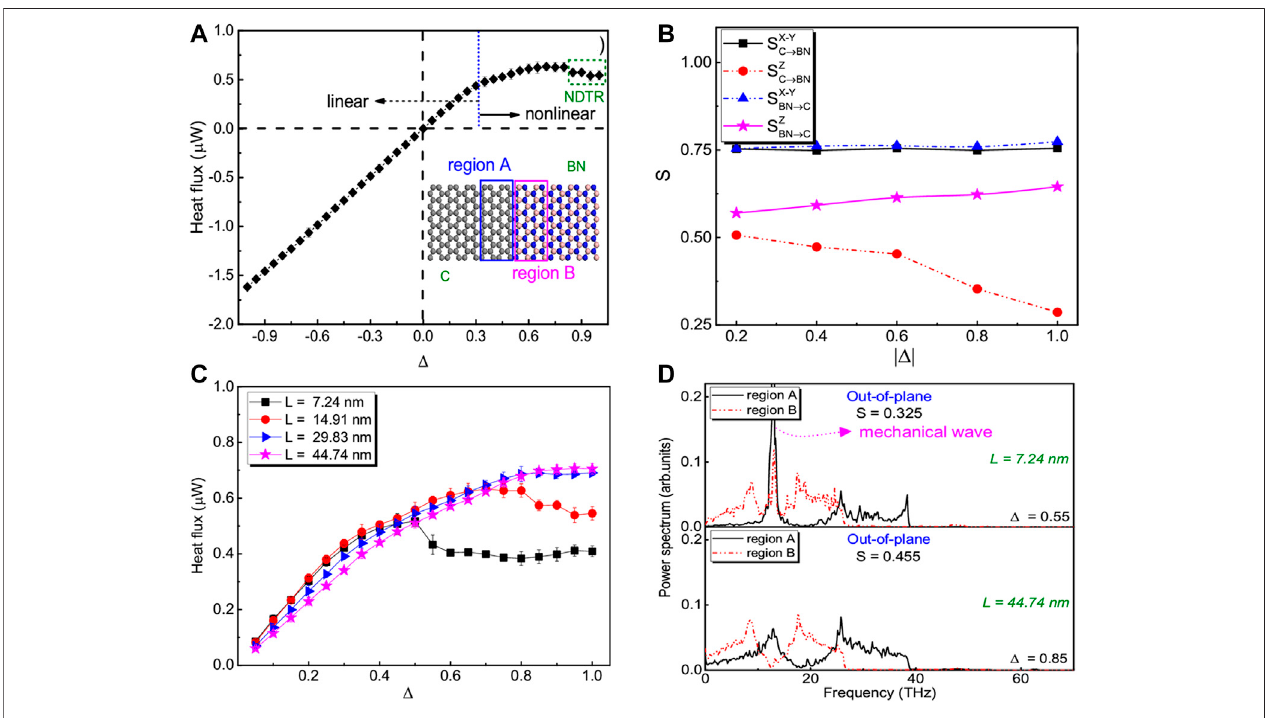
FIGURE 9 | (A) Heat fl ux J vs. temperature bias Δ for the graphene/h-BN heterojunction. Here, T L (cid:1) 500K and TR ranges from 480 K to 100 K. (B) The temperature bias dependence of matching coef fi cients S between the in-plane/out-of-plane power spectra of graphene and h-BN regions. The dependence of (C) NDTR and (D) out-of-plane spectra vs. the heterojunction width. Reproduced from (Chen et al., 2017b) with permission from AIP Publishing LLC.